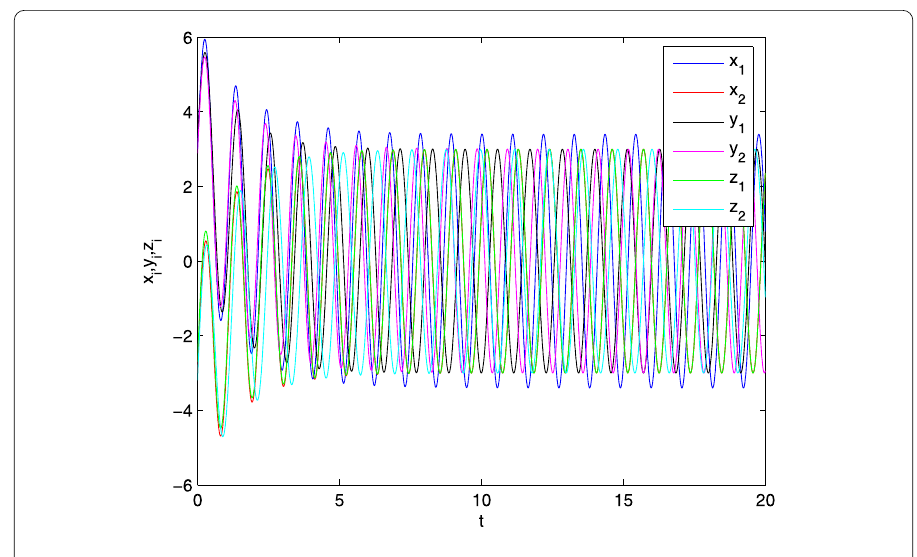
Figure 3 For i , j = 1,2, trajectories of x i ( t ), y i ( t ) and z i ( t ) in system